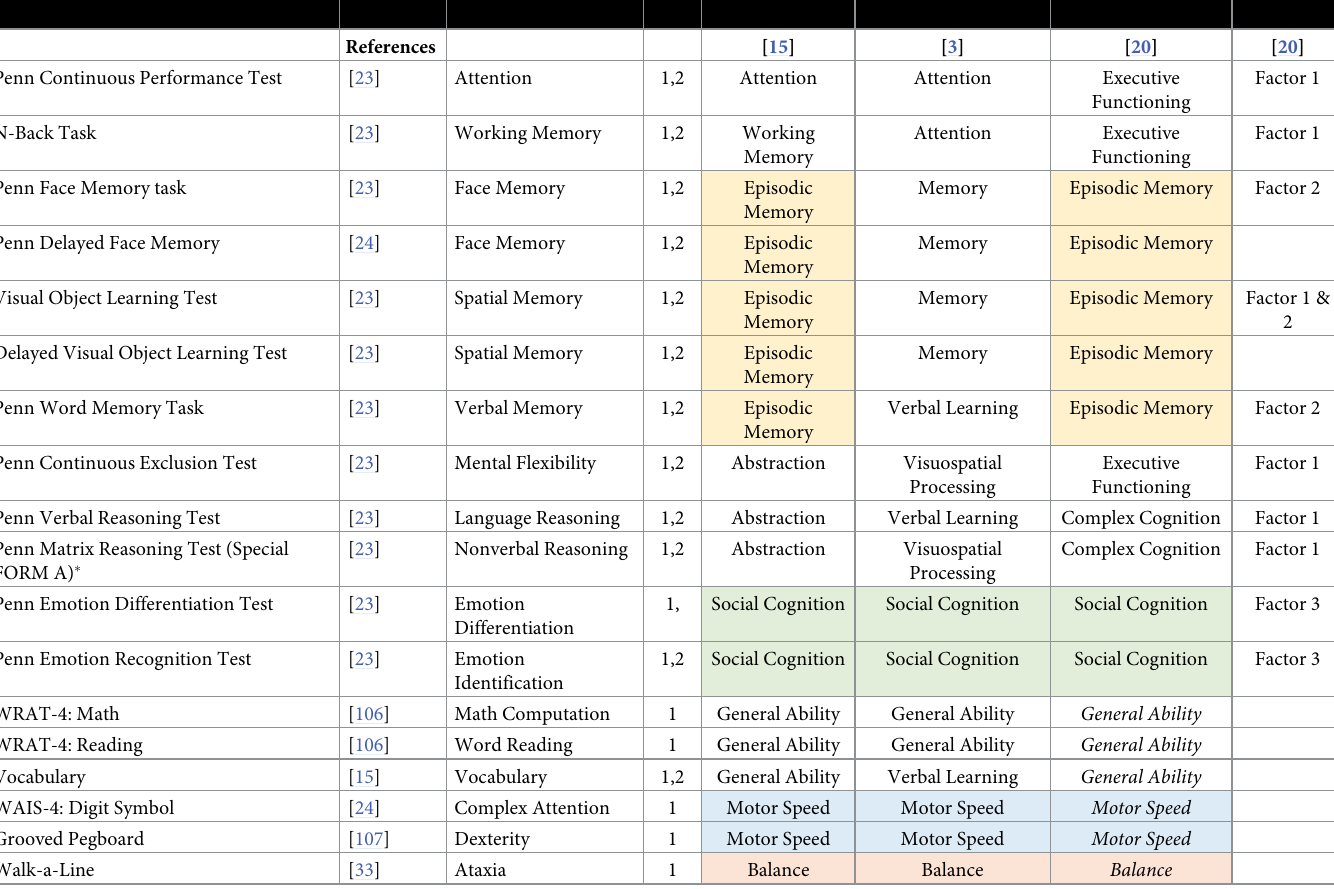
Table 1. Configural models evaluated in this